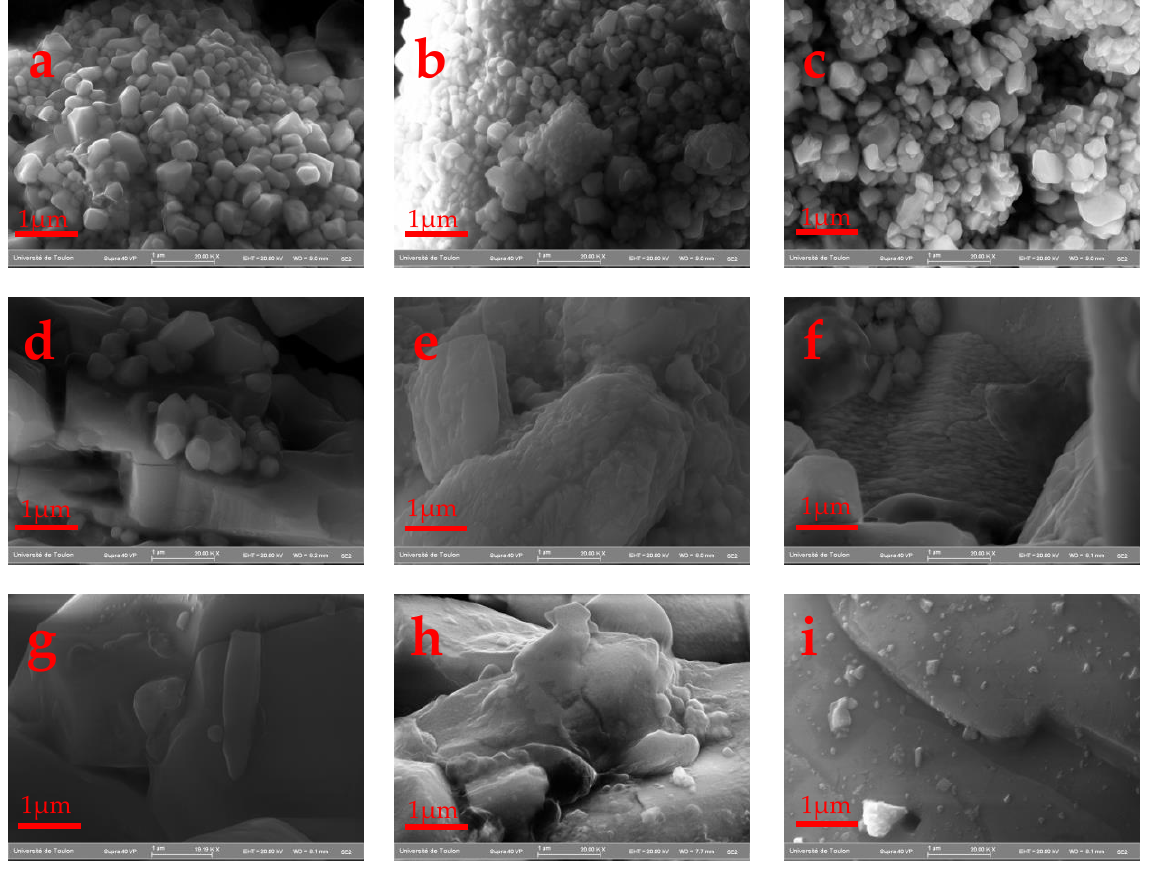
Figure 3. SEM images of: ( a ) BiP-500, ( b ) BiP-550, ( c ) BiP-600, ( d ) BiP-650, ( e ) BiP-700 ( f ) BiP-750, ( g ) BiP-800, ( h ) BiP-850 and ( i ) BiP-900. Table 3. EDX analyses for Bi and P atoms.